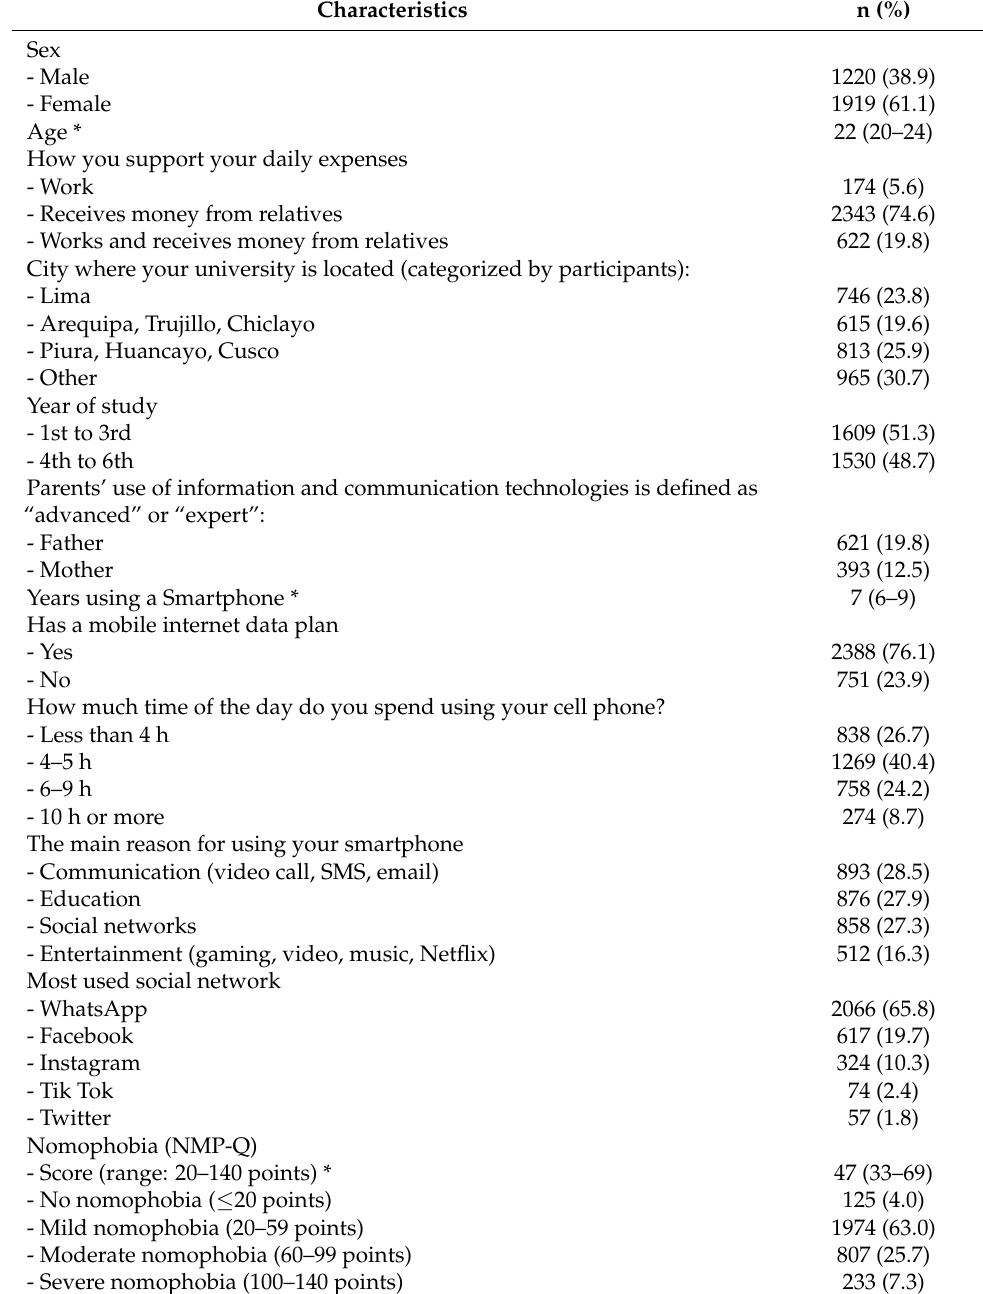
Table 1. Characteristics of surveyed students (n = 3139).